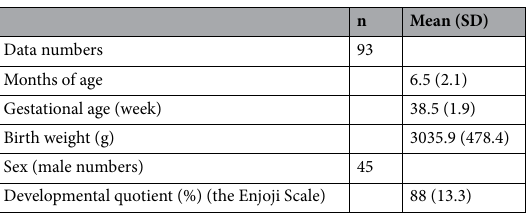
Table 1. Participants characterization data. n number of participants, SD standard deviation.